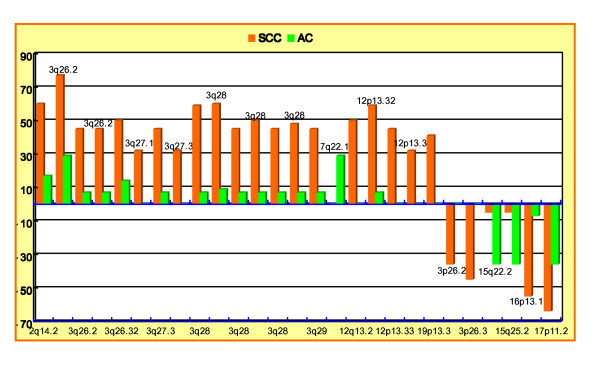
The statistically significant genomic regions preferentially gained and lost between SCC and AC of NSCLC patients. Significant genomic regions between SCC and AC of NSCLC represent in the x-axis and the percentage of gains (upper panel) and losses (lower panel) expressed regions in each chromosomal regions is illustrated to the y-axis (red bars represent the SCC and green bars represent ACs).